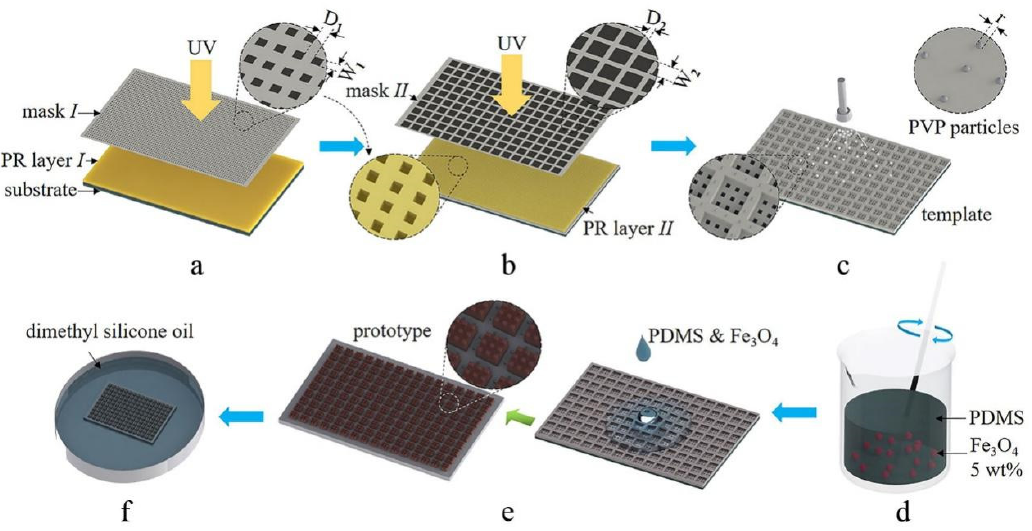
Figure 1. Schematic of HD-PTSS fabrication. ( a ) UV lithography step I . ( b ) UV lithography step II . ( c ) Spray particle modifying. ( d ) Photothermal colloid preparation. ( e ) Reverse molding. ( f ) Lubricant infusion.